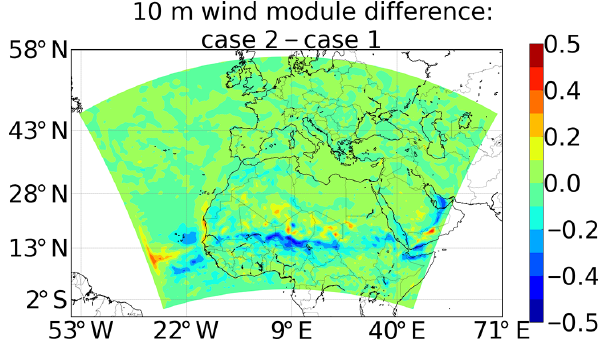
Figure 11. The 10m high wind module difference map between online case 1 and case 2 (in ms − 1 ) averaged in time over the period ranging from 1 June to 14